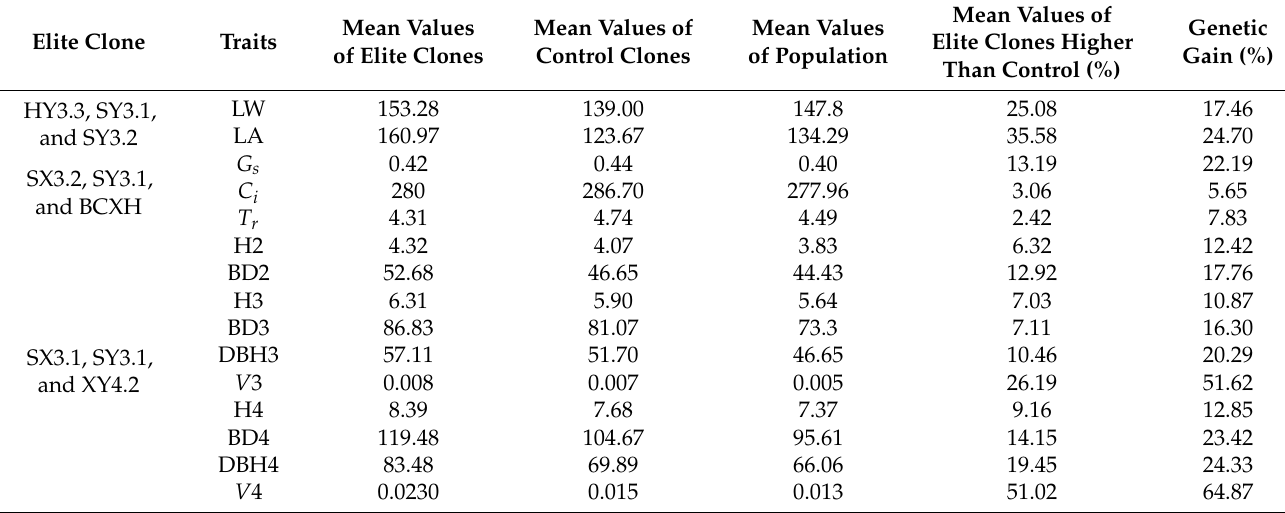
Figure 3. Comprehensive scores of different clones. Table 4. Comprehensive evaluation of elite clones.